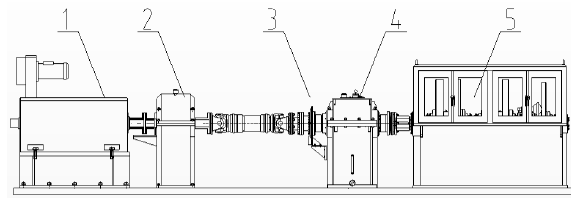
Figure 14. Structure of a standard inertia calibration test.